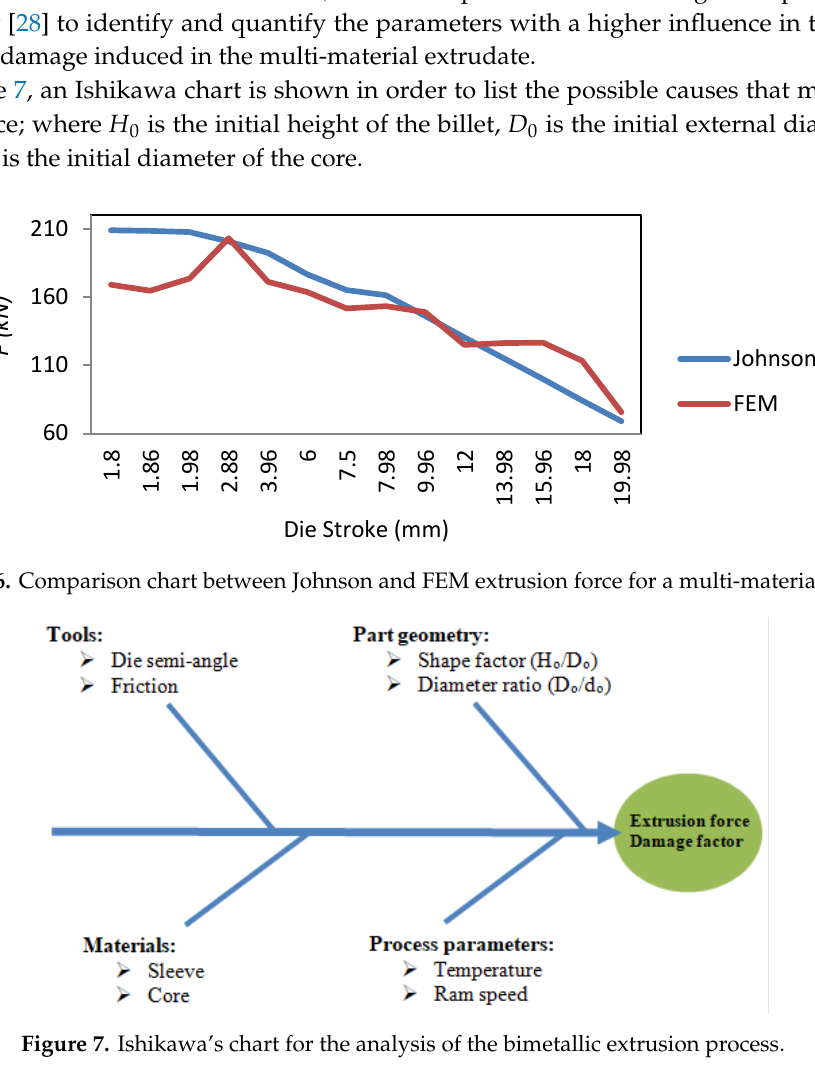
Figure 7. Ishikawa’s chart for the analysis of the bimetallic extrusion process.